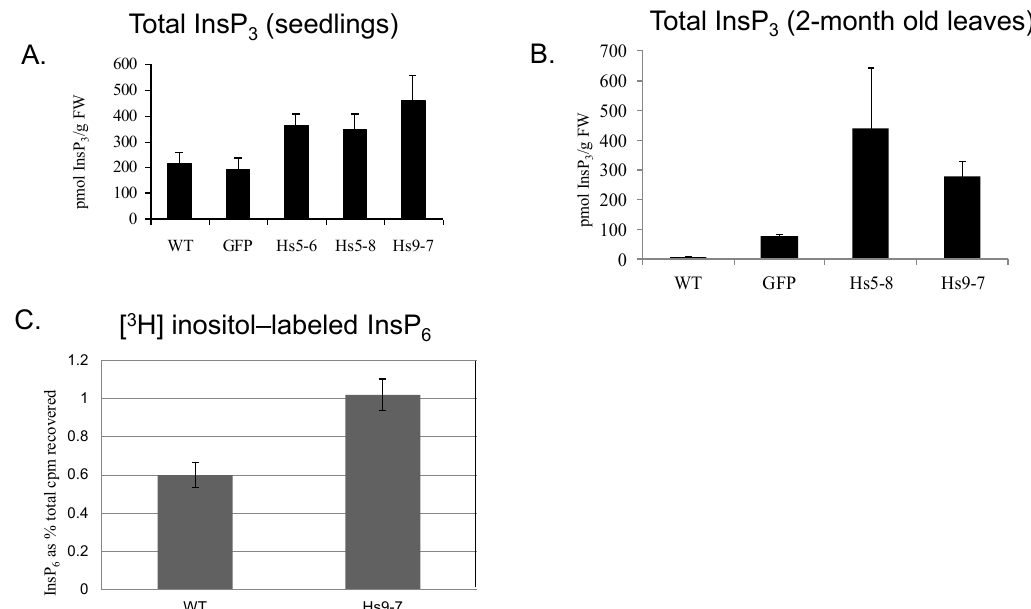
Figure 6. InsP increased in the Hs PIPKIα plants. Based on mass measurement, basal 3 Ins(1,4,5)P is higher in the 2 week-old Hs PIPKIα seedlings ( A ) and in leaves of 2 month-old 3 Hs PIPKIα plants harvested in the afternoon ( B ); [ 3 H] myo -inositol labeling of seedlings indicates increased [ 3 H] InsP production ( C ); The data are the mean ± SD of duplicate 6 samples from two biological